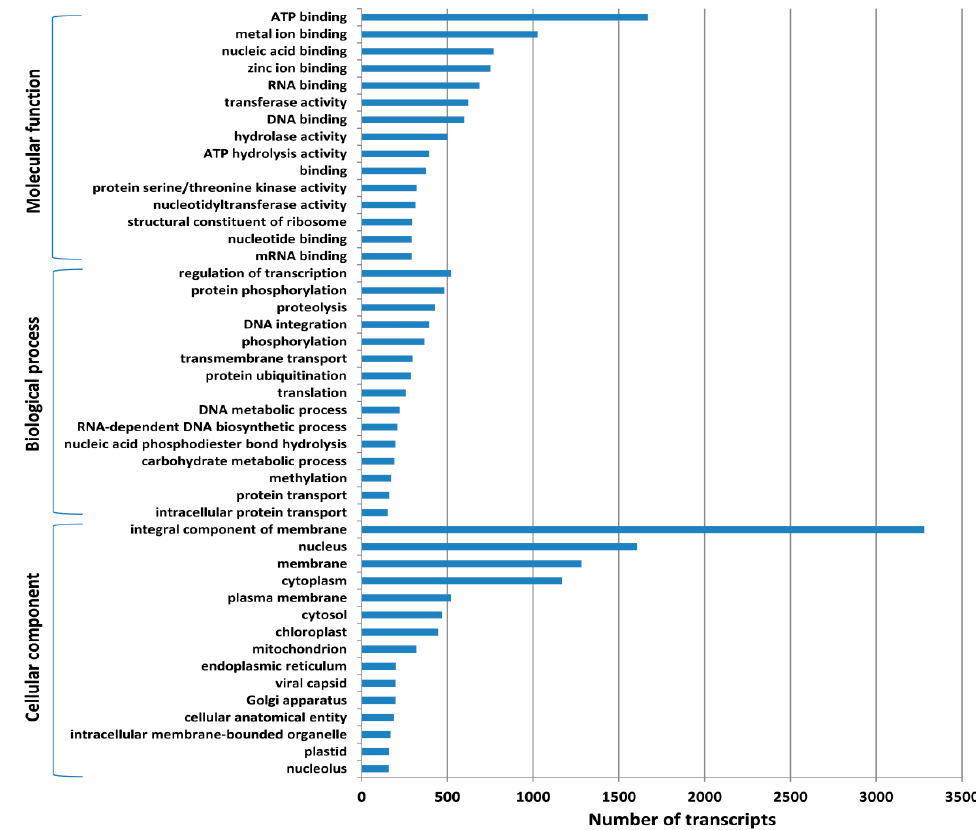
Figure 3. Functional classification of transcripts based on GO terms, distributed in three major categories: molecular function, biological process, and cellular component.